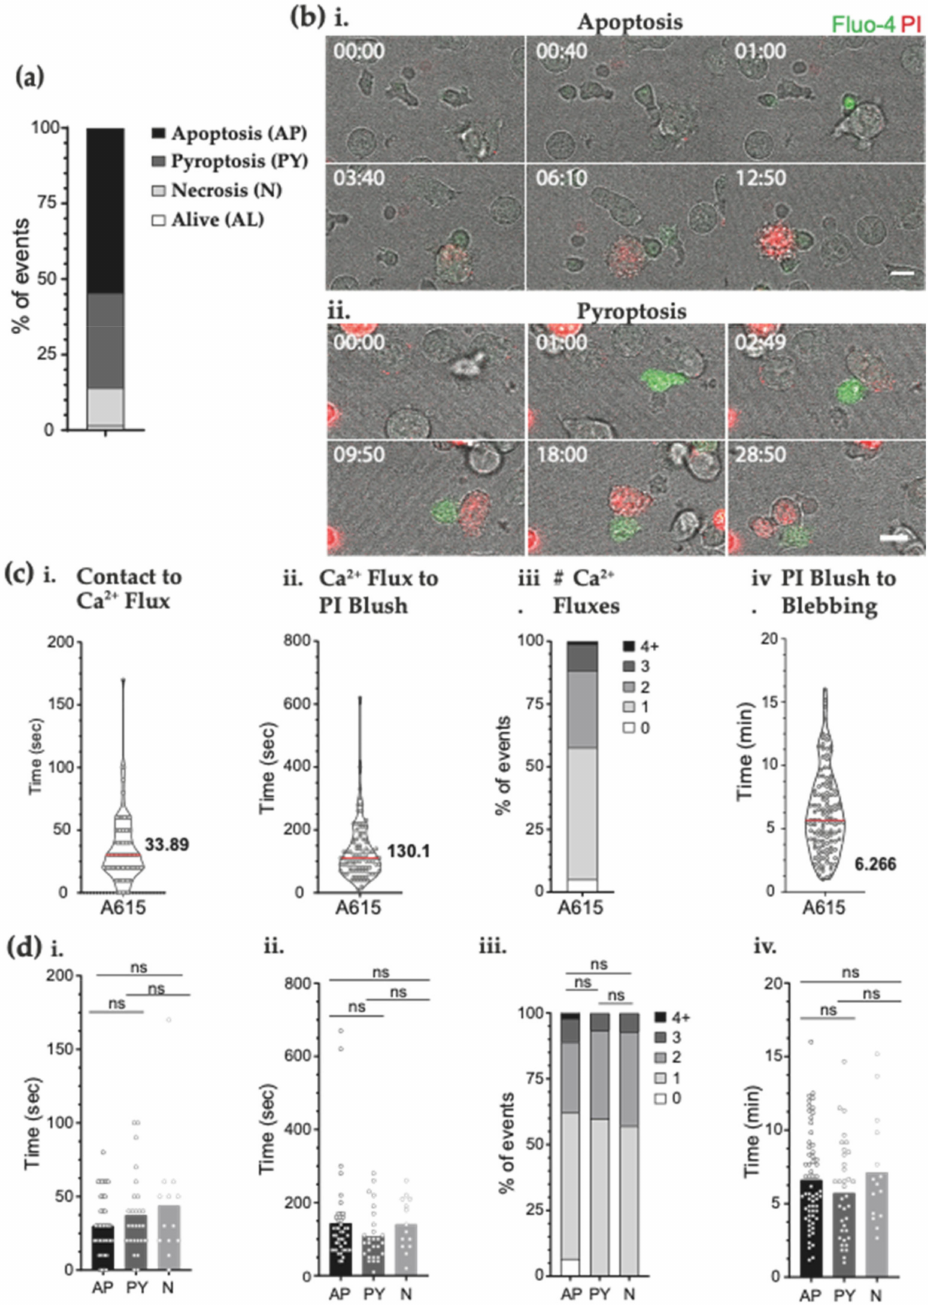
Figure 3. Live cell imaging of H3.3-K27M-specific mouse CD8 CAR T cell cytotoxic response. Time-lapse microscopy of Fluo-4-AM-labelled GCT615-CAR T cells (‘A615 (cid:48) ) killing T2-K27M targets in the presence of 200 µ M PI. Data pooled from two independent experiments across 26 fields of view. ( a ) Proportion of T2-K27M target cells that had displayed PI uptake after T cell immune synapse formation with a CD8 GCT615-CAR T cell stratified by either apoptosis (AP), pyroptosis (PY) or necroptosis (N) (54.26%, 31.01% and 12.40% respectively). n = 129 events. ( b ) Representative live cell imaging montage of GCT615-CD8 + CAR T cell killing T2 targets. CAR T cells are labelled with calcium flux indicator Fluo-4 (green); propidium iodide is in media at 200 µ M (red) showing (i) apoptosis or (ii) necroptosis ( respectively).